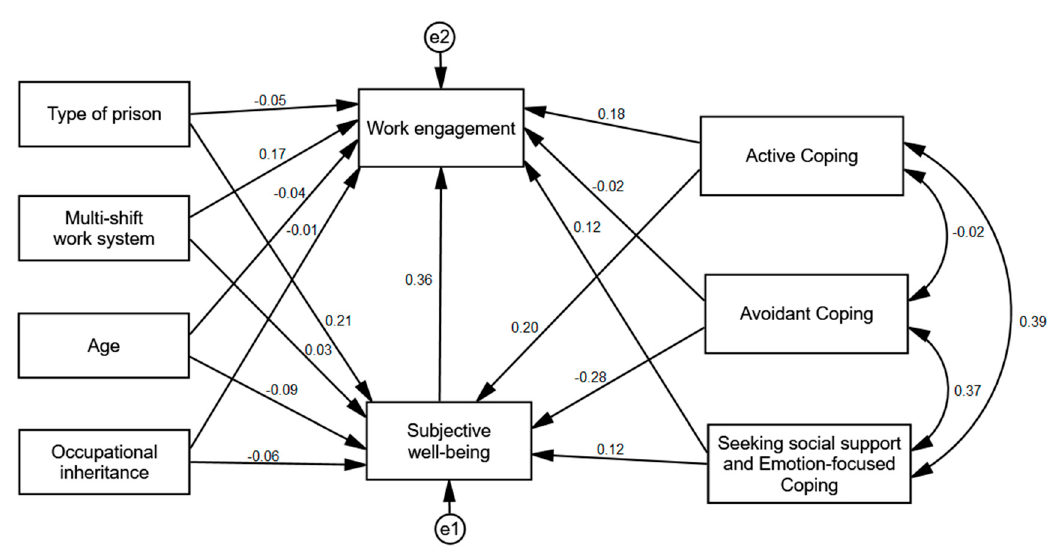
Figure 2. Standardized regression coefficients for the explanatory path model of work engagement in the group of Polish POs.